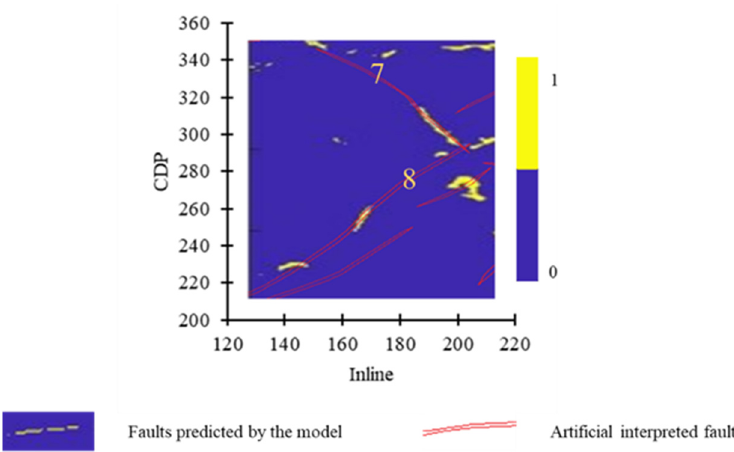
Figure 22. The prediction result of Faults 7–8 by Region D as training set .